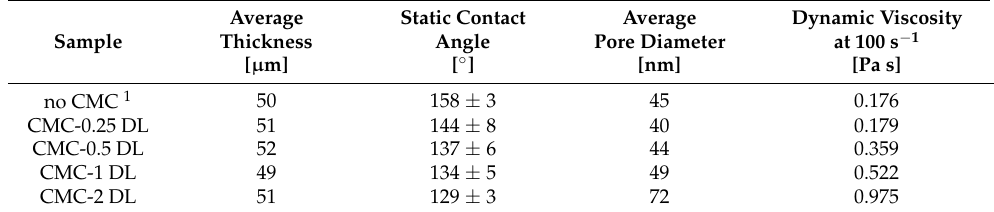
Table 2. Average thickness of the MPLs, static contact angle (MPL side), average pore diameter of the GDMs and dynamic viscosity (at shear rate of 100 s − 1 ) of the inks used to deposit the MPLs.